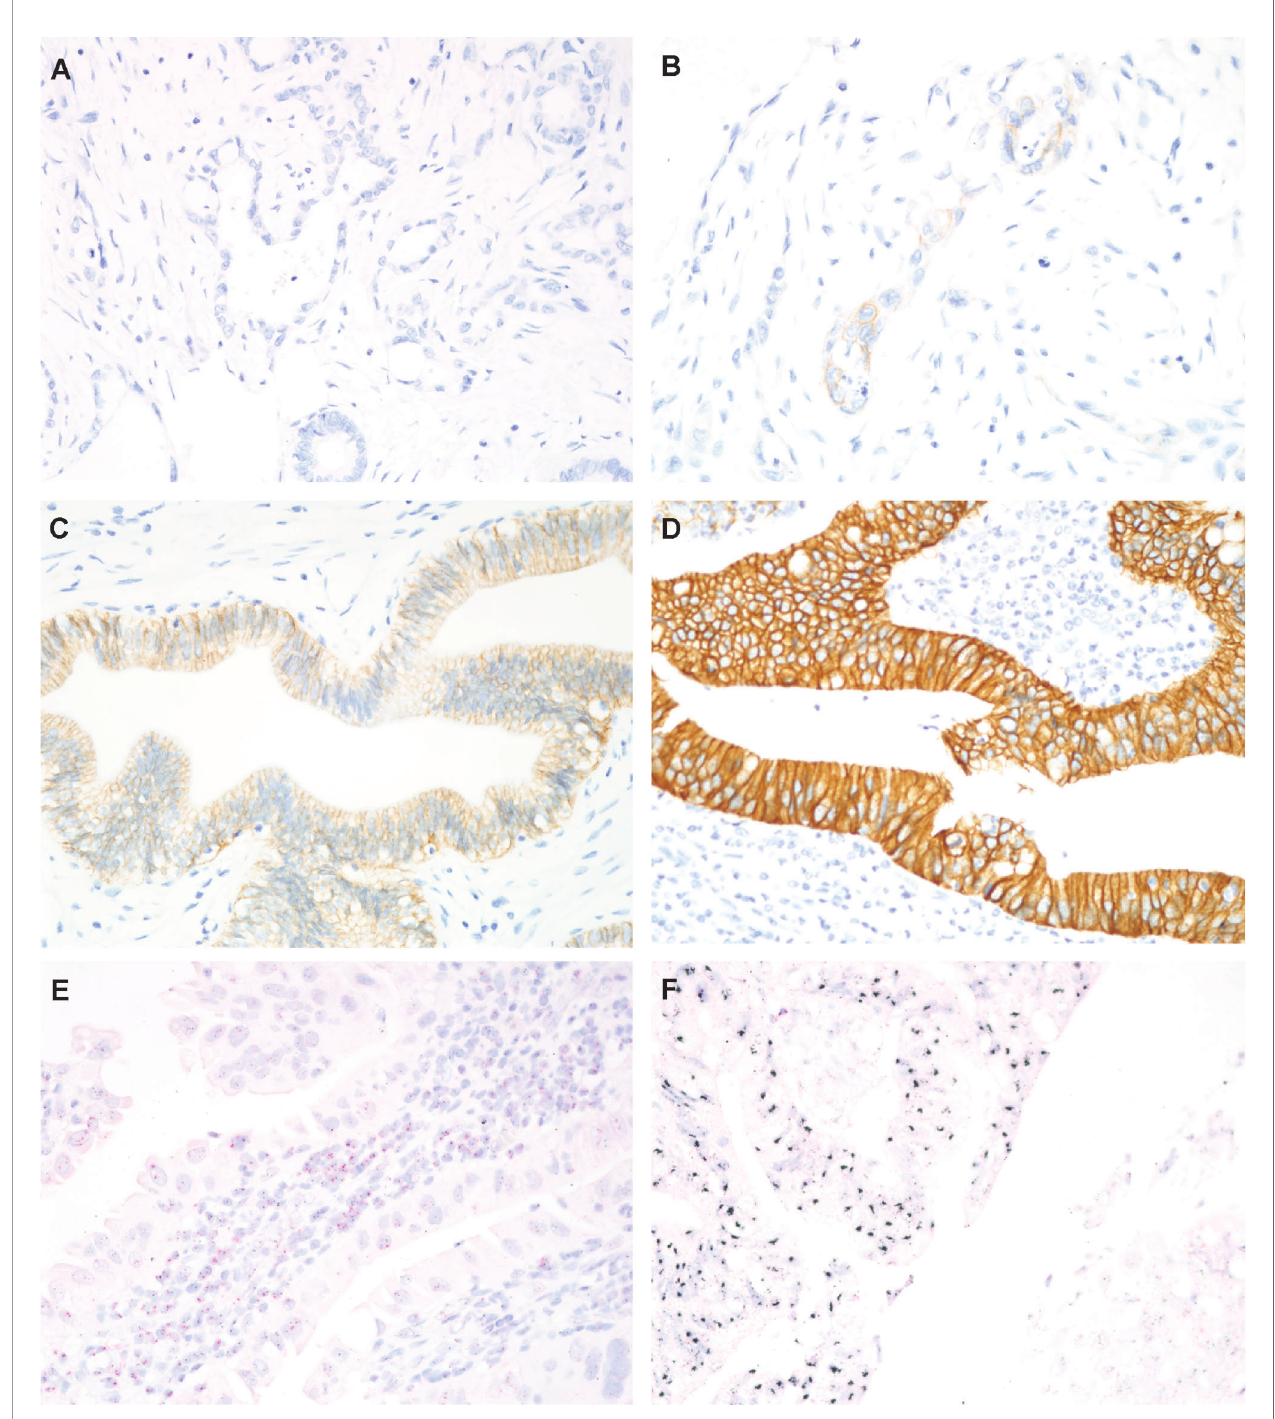
FIGURE 1 | Representative images of HER2 immunohistochemical (IHC) staining and HER2 silver in situ hybridization (SISH). (A) HER2 IHC score 0, no expression (magni fi cation, 400×); (B) HER2 IHC score 1+, barely visible (400×); (C) HER2 IHC score 2+, weak to moderate staining (400×); (D) HER2 IHC score 3+, intense staining (400×); (E) Absence of HER2 ampli fi cation in cases with HER2 IHC score 0; (F) HER2 ampli fi cation in cases with HER2 IHC score 3+. Red dots correspond to CEP17, and black dots correspond to HER2 (magni fi cation,